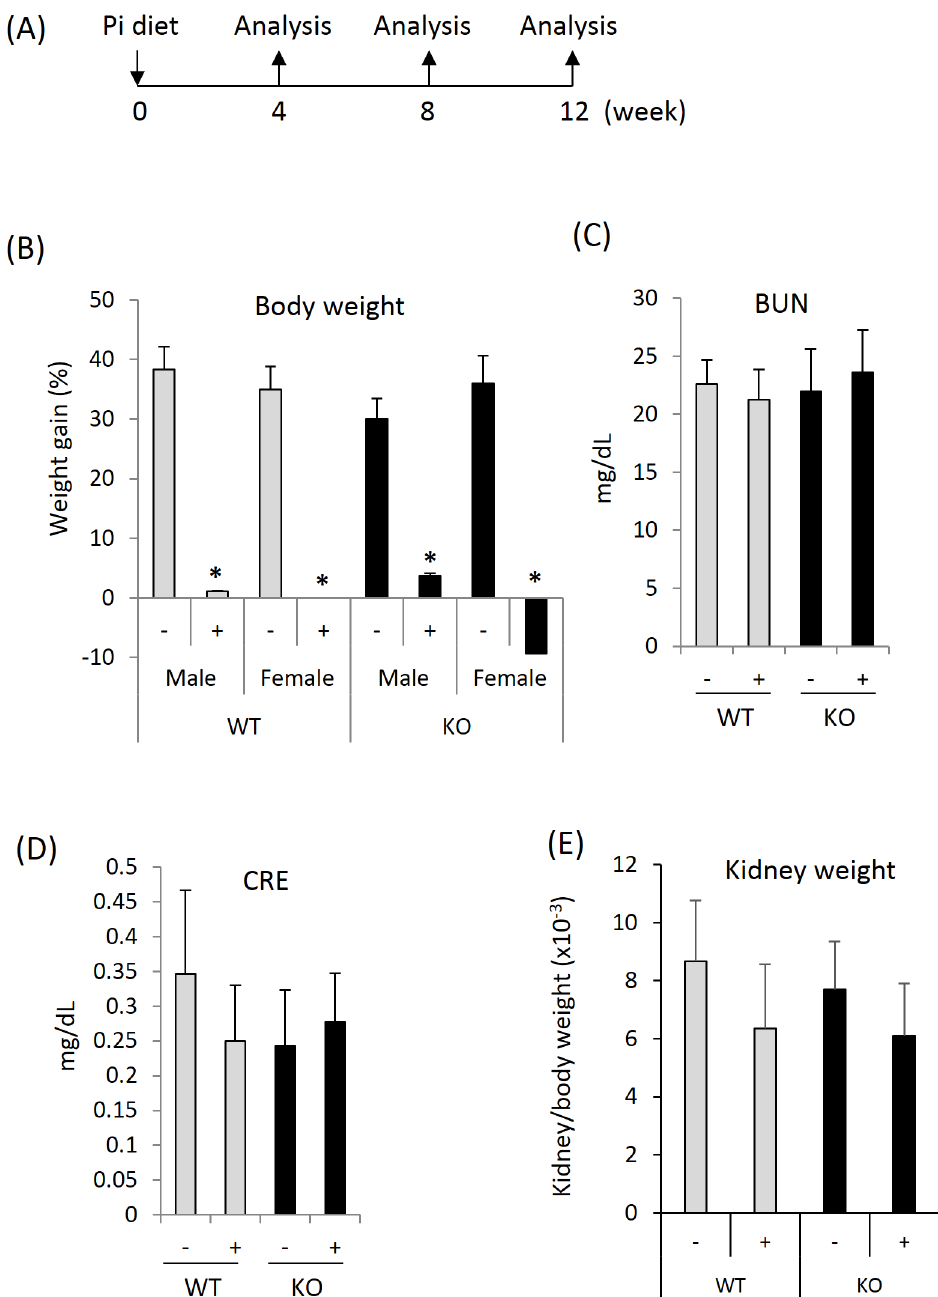
Fig 1. Organ and body weight and serum biochemistries after HPD. (A) 12-week old WT or Pin1 KO mice were fed HPD for 4, 8, 12 weeks before analysis. (B) Mouse body weights were measured at the beginning and end of normal diet (-) and HPD (+), and expressed as % increase compared to the weight at the beginning of diet given. * denotes p < 0.01 between treatments with 6 mice/group. (C) and (D) Serum from each mouse was collected at the end of diet (12 weeks) and measured for the indicators of kidney function. (E) Kidney weight at the end of diet.